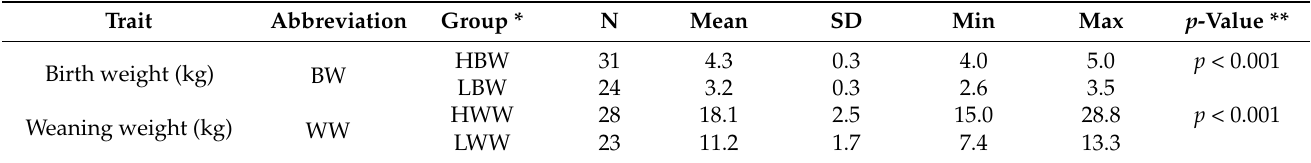
Table 1. Descriptive statistics of lamb growth traits.